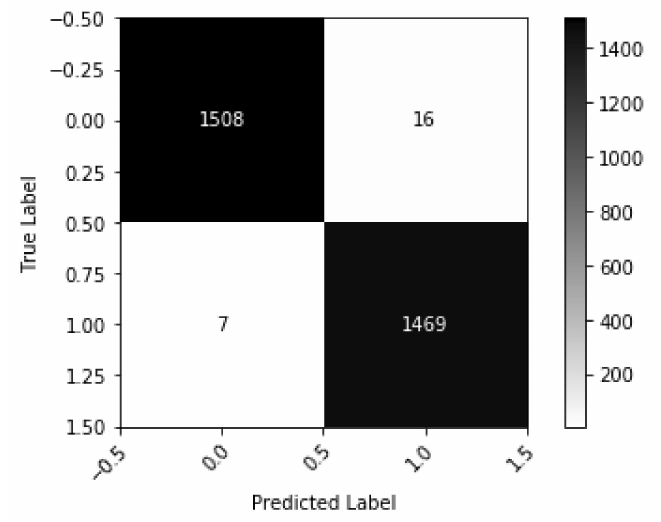
Figure 13. Confusion Matrix of Autoencoder based model based on test